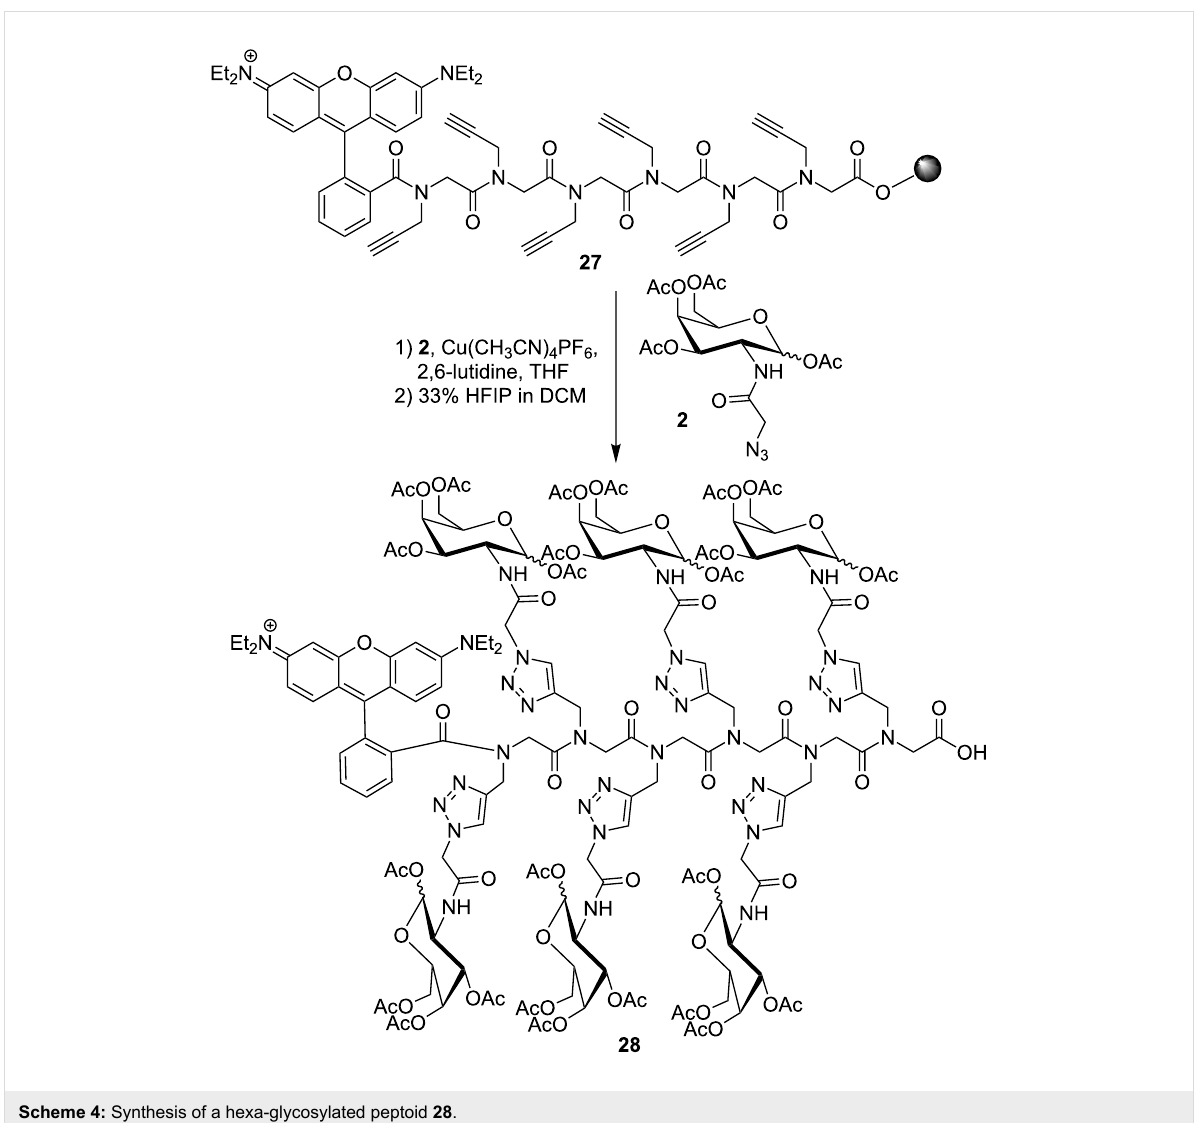
Scheme 4: Synthesis of a hexa-glycosylated peptoid 28